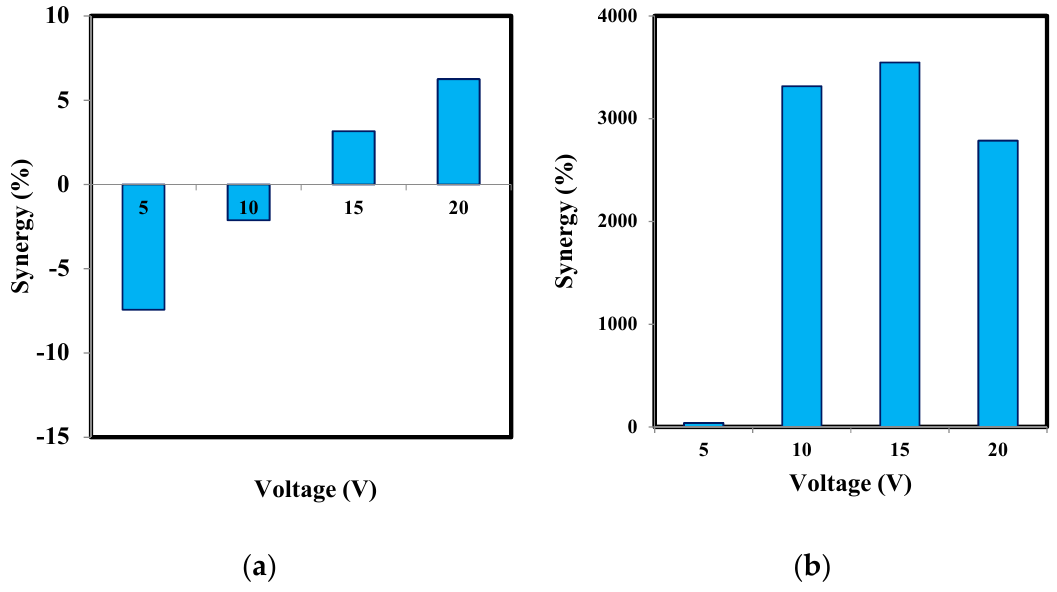
Figure 5. Comparative study of synergy parameter for RNO decolorization ( a ) in 3D systems using GACs as particle electrodes and ( b ) in a 3D system using NCPEs as particle electrodes.